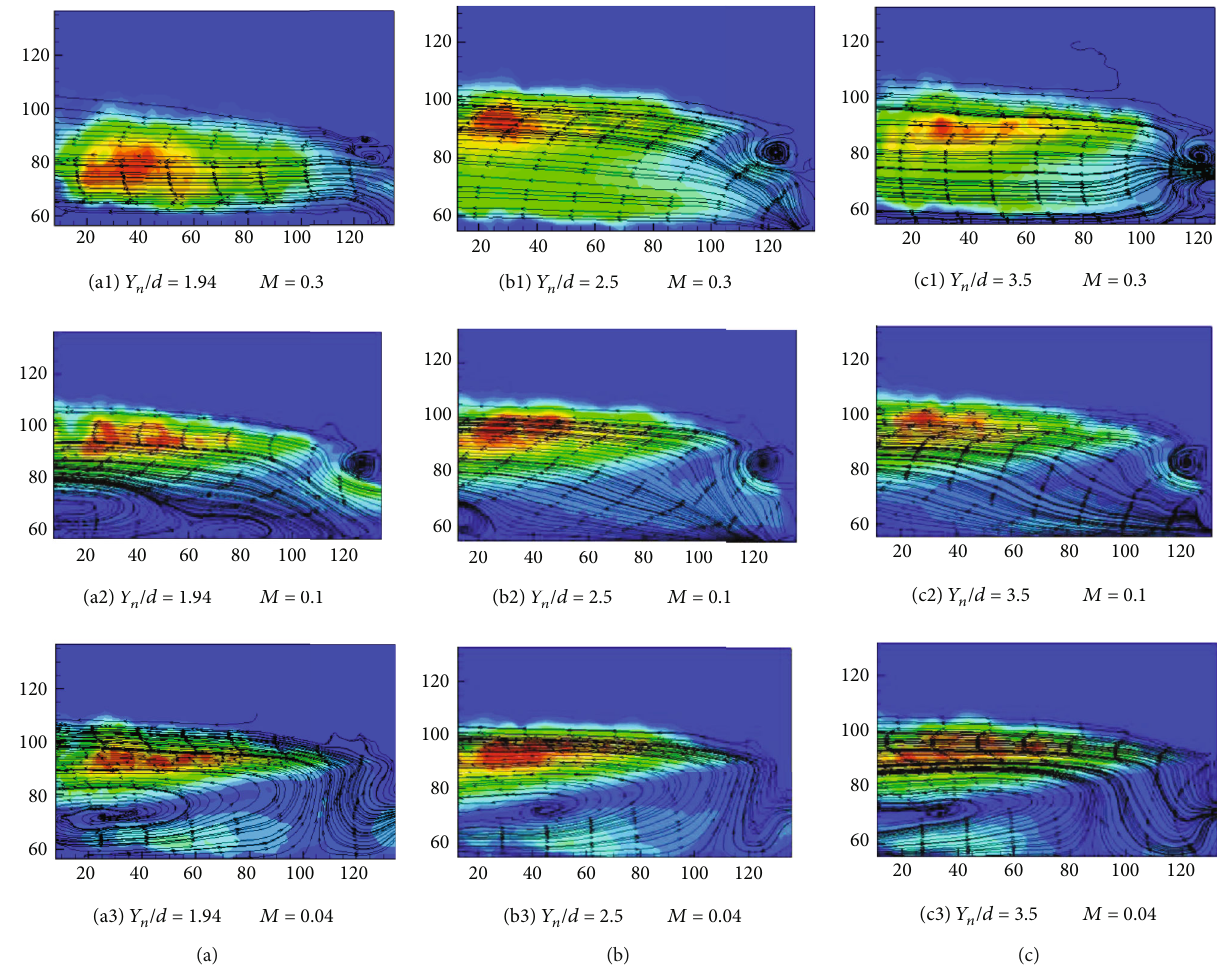
Figure 11: Flow fi eld pattern at di ff erent spacing of impinging the fi lm layer above the red line in Figure 8) does not change signi fi cantly. When the blowing ratio is 0.3, the secondary coolant air fl ow streamline changes from parallel wall to sepa- ration from the wall as the jet-to-plate pitch increases, and the e ff ect of cooling gas covering the wall becomes worse. When the blowing ratio is 0.04 and 0.1, there is a near-wall entrained vortex downstream of the slit. As the jet-to-plate pitch increases, the location of the vortex center moves downstream, and the size of the vortex increases at the same time. This is because the larger the jet-to-plate pitch, the larger the area where the reverse pressure gradient is generated downstream of the slit. In summary, more cooling air needs to be con- sumed as jet-to-plate pitch increases under the condition of the same blowing ratio. At the same time, the size of the entrained vortex downstream of the slit outlet increases, and the near-wall air fl ow is severely separated. In engineering